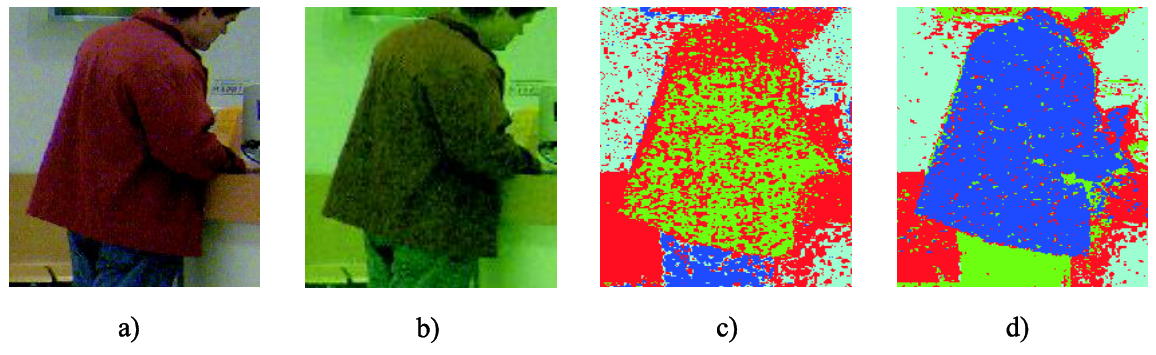
Figure 12. Reference images for the example of Figure 11. Example of original and injected images segmentations: (a) original image, I, (b) injected image, I image segmentation according to the projected classes in Figure 11a and (d) injected image segmentation according to the projected classes in Figure